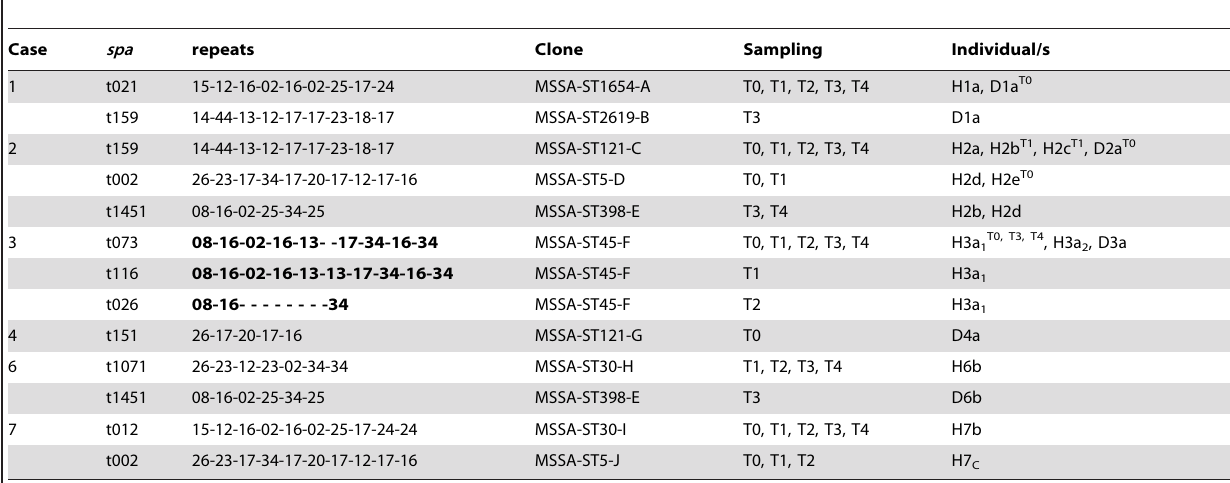
Table 2. Different spa types present among the S. aureus clones per household during the sample period (T0–T4), positive individuals and correspondent clones.